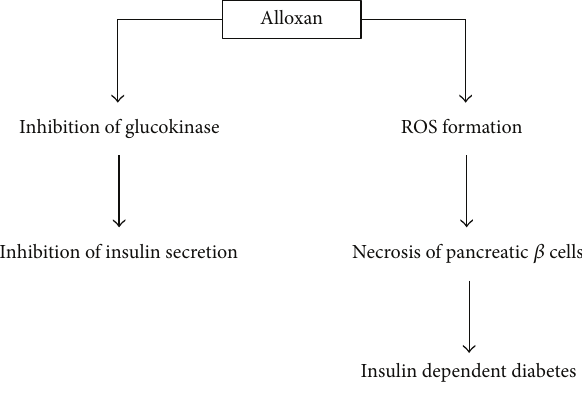
Figure 3: The main pathological effects of